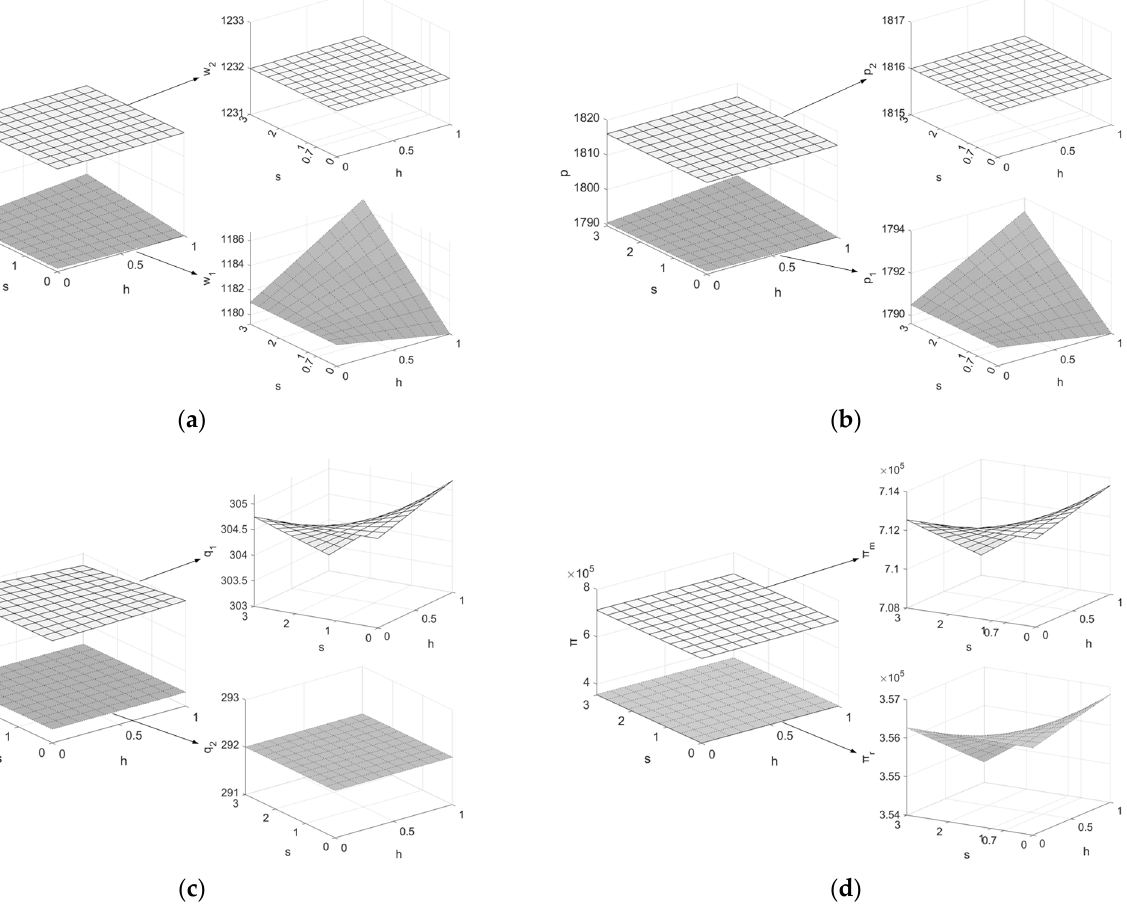
h h s s Figure 2. Effects of h and s on decision variables. ( a ) Effects of h and s on w 1 , w 2 ; ( b ) effects of h and s Figure 2. Effects of and on decision variables. ( a ) Effects of and on on p 1 , p 2 ; ( c ) effects of h and s on q 1 , q 2 ; ( d ) effects of h and s on π m , π r , π . h s and on From Figure 2: (1) When the value of s is below the threshold value s 1 , the s s From Figure 2: (1) When the value of is below the threshold value 1 , the carbon